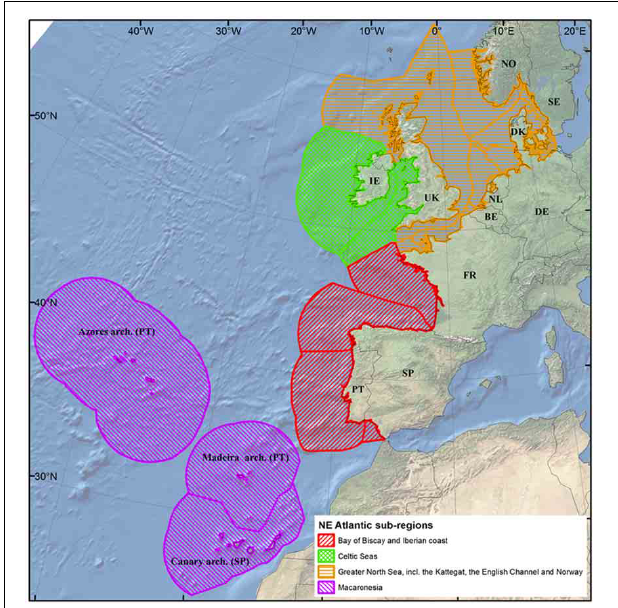
FIGURE 1 | European North Atlantic Ocean sub-regions. Spatial limits are based on the Marine Strategy Framework Directive and Exclusive Economic Zone of the countries located in each sub-region. BE, Belgium; DK, Denmark; FR, France; DE, Germany; IE, Ireland; NL, Netherlands; NO, Norway; PT, Portugal (including Azores archipelago and Madeira archipelago); SP, Spain (including Canary archipelago); SE, Sweden; and UK, United